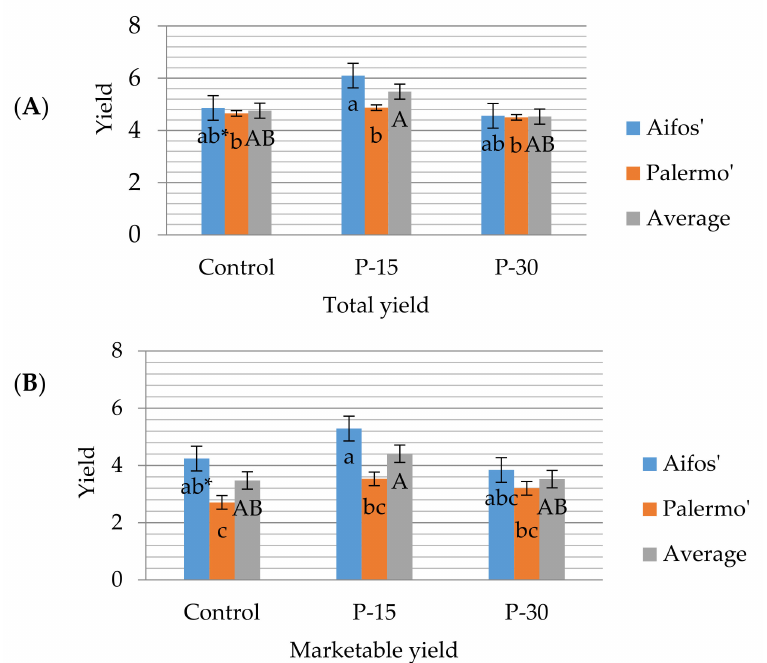
Figure 2. ( A , B ) E ff ect of fertilizer with polyphosphates in hydroponic cultivation on the total ( A ) and marketable ( B ) yield depending on the sweet pepper cultivar (kg plant − 1 ). * The bars marked with the same letters do not di ff er significantly according to the Tukey HSD test at α =